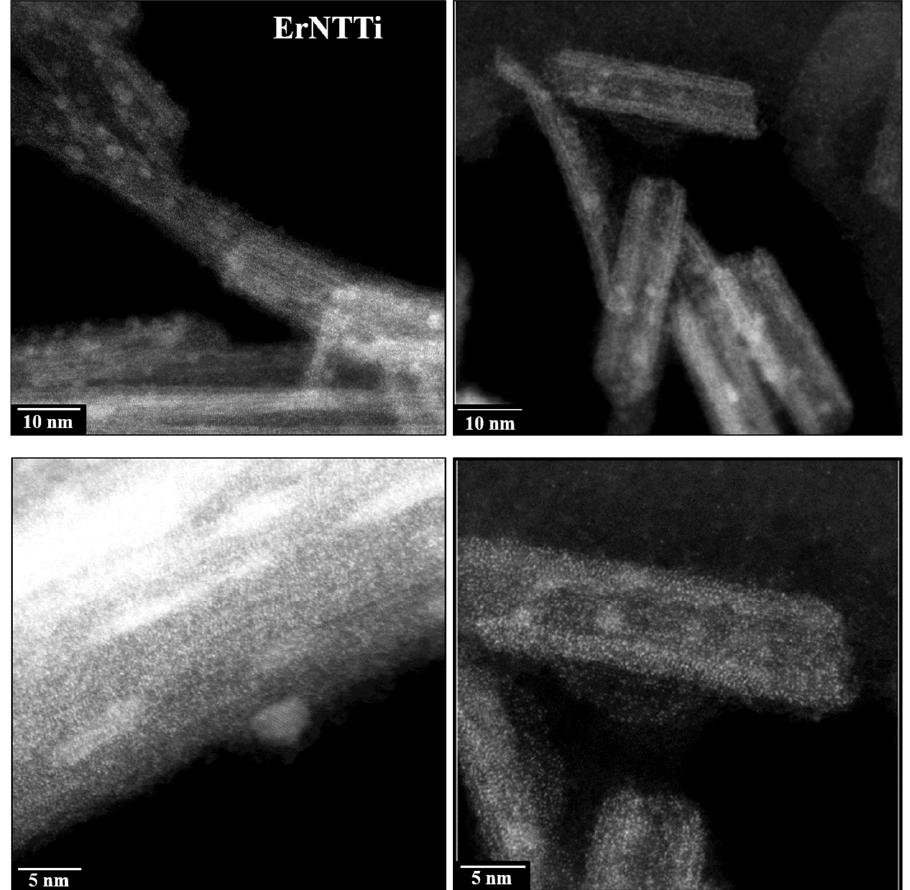
Figure 6. HAADF-STEM images of ErTiNT showing Er-based NPs and NPs of TiO 2 anatase on the surface of titanate nanotubes. The two NPS are lighter than TiNTs; however, Er-based NPs are smaller and have higher brightness.